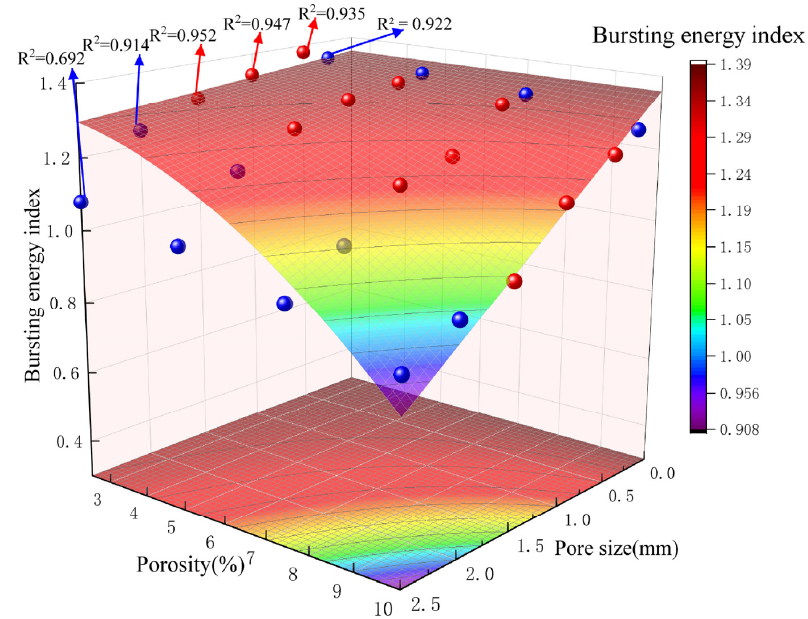
Figure 15. Impact energy index fitting effect.